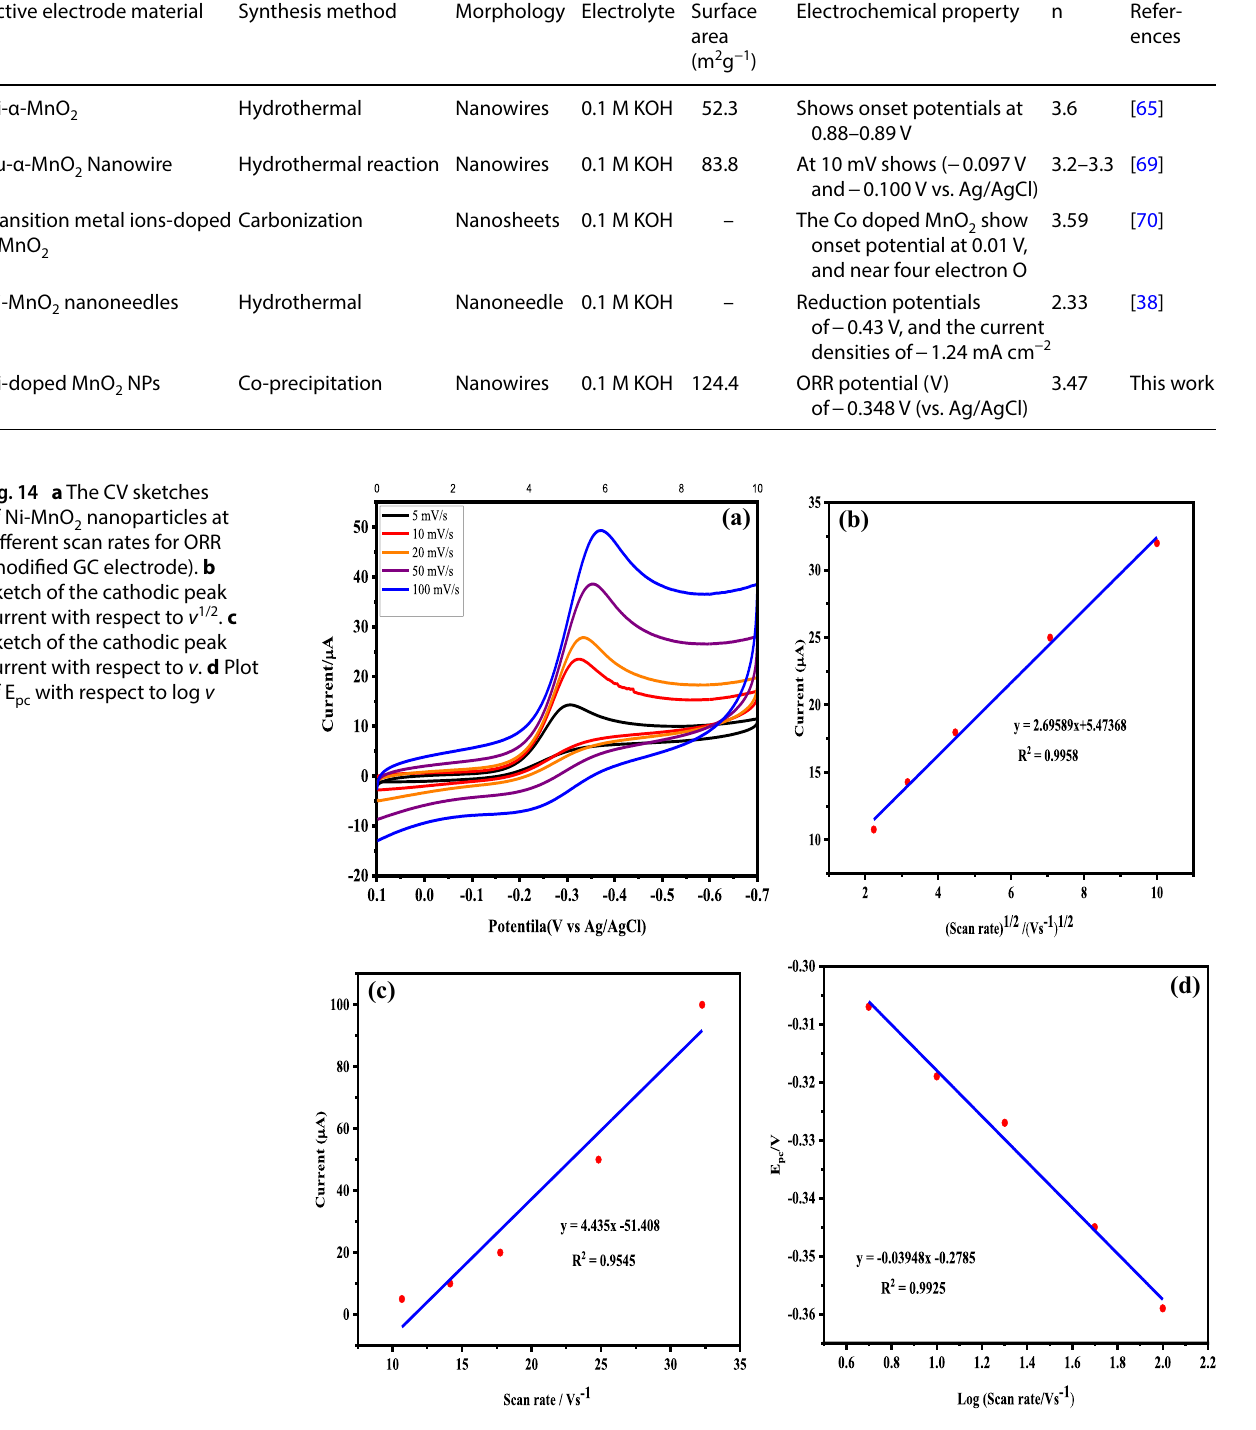
Table 4 Comparison of electrochemical properties of recently studied MnO Active electrode material